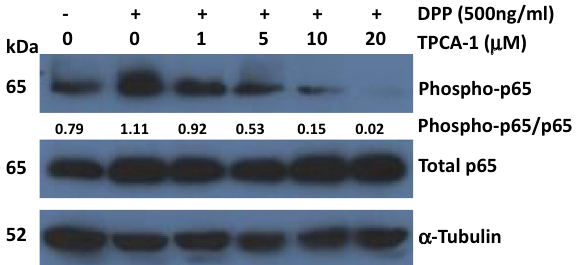
Figure 1. Activation of NF-κB subunit p65 by DPP. DPSCs were treated with DPP in the presence and absence of the NF-κB inhibitor TPCA-1. Varying concentrations of TPCA-1 were used as indicated. Total and phosphorylated levels of NF-κB subunit p65 were examined by Western blot. Note higher concentrations of TPCA-1 blocked activation of p65. Tubulin was used as a loading control. The relative density ratio of phospho p65 to total p65 protein bands normalized to tubulin are